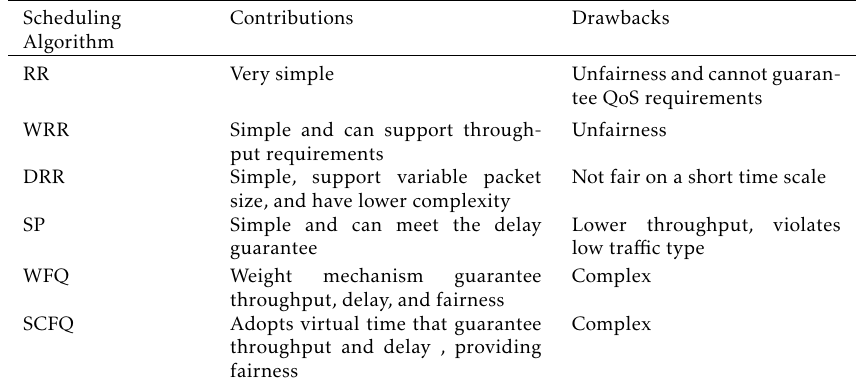
Table 2. Conventional QoS Scheduling Algorithms